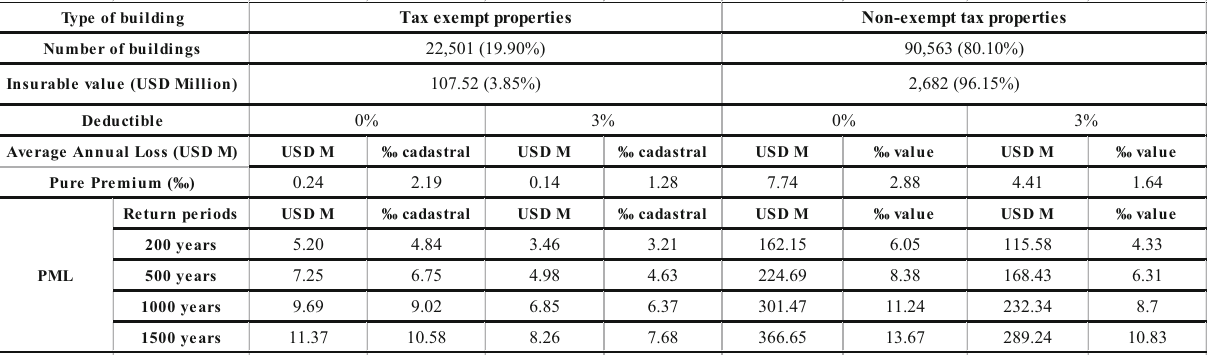
Table 3 Risk results for private buildings (tax exempt and non-exempt), with 0 and 3% deductible (Agreement 760, 2011) a in Manizales,